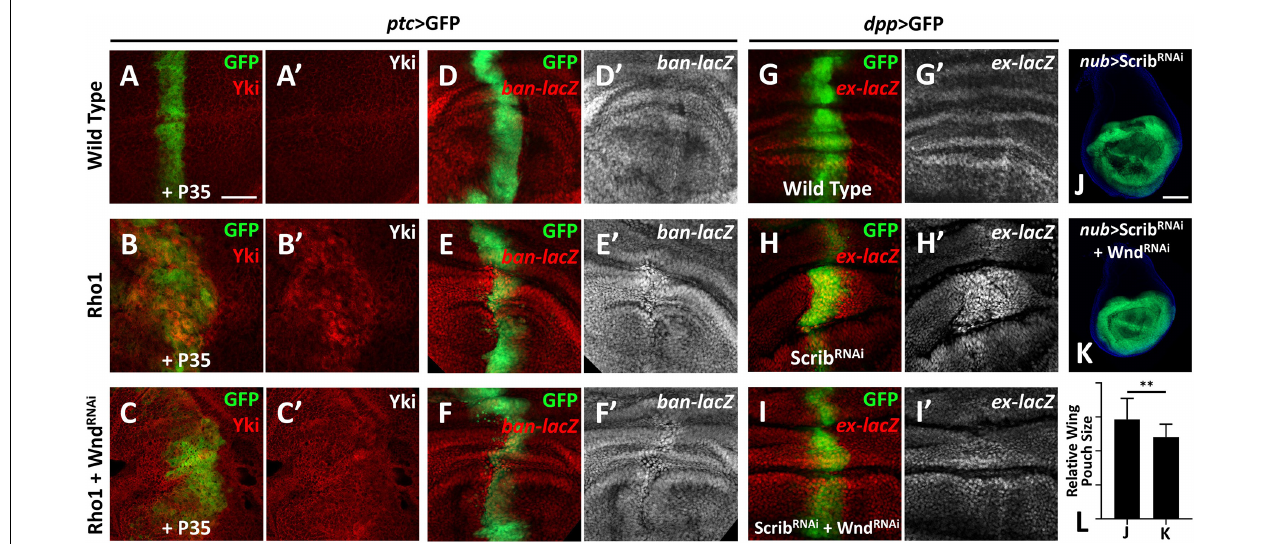
FIGURE 2 | Wnd is essential for Rho1 activation and cell polarity loss-induced Hippo inactivation. (A–K) Wing imaginal discs from third instar larva with genes or RNA is expressed in GFP positive area are shown. (A–C (cid:48) ) Compared with wild type controls (A,A (cid:48) ) , expression of Rho1 together with P35 enhances Yki nuclear localization (B,B (cid:48) ) , which is rescued by knocking down wnd (C,C (cid:48) ) . (D–F (cid:48) ) Compared with wild type controls (D,D (cid:48) ), expression of Rho1 induced ban upregulation (E,E (cid:48) ) is suppressed by knocking down wnd (F,F (cid:48) ) . (G–I (cid:48) ) Compared with wild type controls (G,G (cid:48) ) , scribble ( scrib ) knockdown upregulates ex transcription (H,H (cid:48) ) and this is impeded by wnd knockdown (I,I (cid:48) ) . (J) Knocking down scrib in the wing pouch region causes tissue overgrowth (J) , which is suppressed by wnd knockdown (K) . Statistical analysis of (J,K) is shown in (L) . Scale bars for (A–I (cid:48) ) , 50 µ m; for (J,K) , 100 µ m. ** P < 0.01. (A Student t -test was used to calculate statistical significance, mean + SD , n =